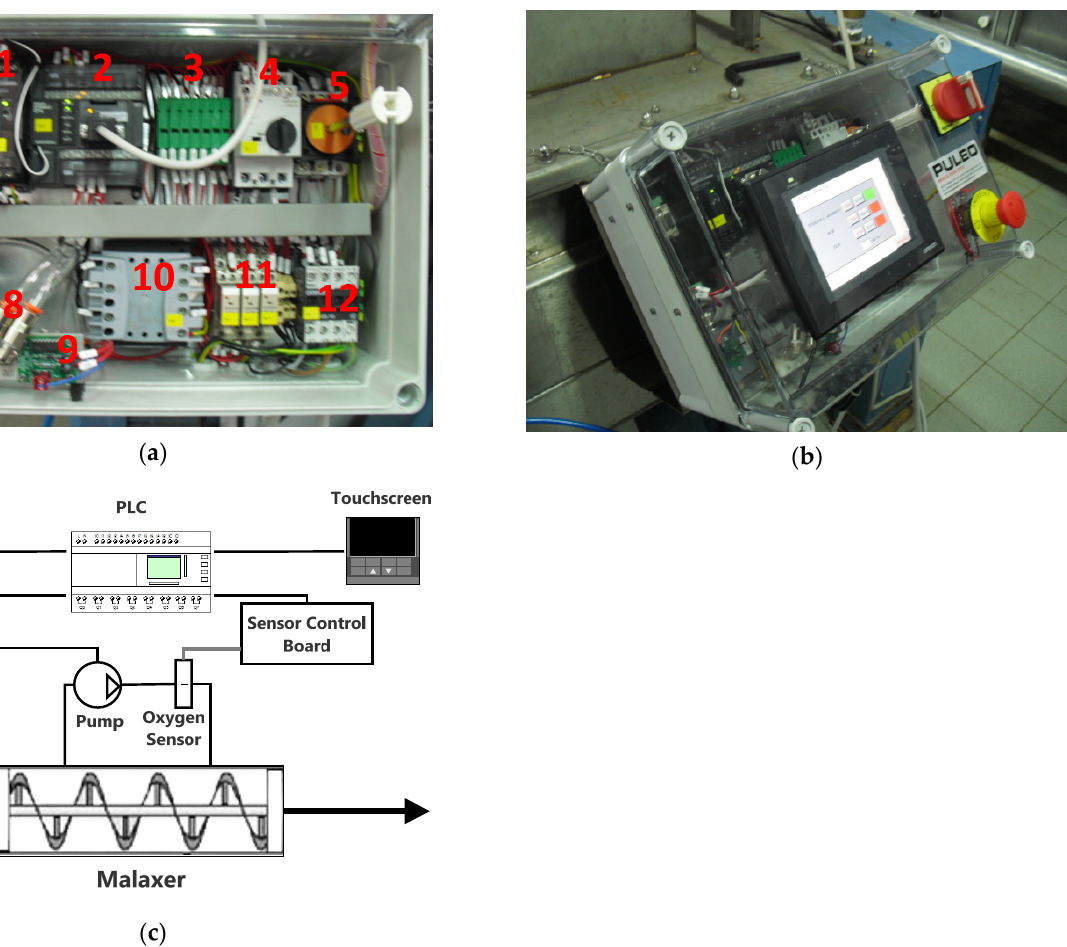
Figure 2. ( a ) SCADA platform inside: 1: 24 V DC power supply for PLC power supply, 2: OMRON CP1L14 PLC with relay outputs, 3: PLC protection fuses, touch panel, sampling pump, and oxygen detection board, 4: thermal-magnetic circuit breaker of the cochlea, 5: 32 A general safety switch, 6: oxygen % detection board with 0–10 V analog output (0.1–25%), 7: zirconium oxide sensor protective case, 8: Rilsan pipes for gas suction/discharge to be analyzed, 9: pump for gas sampling (flow 1 L/min), 10: 63 VA transformer, 11: activation relay: oxygen/nitrogen valves, cochlea, 12: cochlea contactor, OMRON 5.7” color touchscreen control panel; ( b ) human–machine interface; ( c ) functional block diagram.